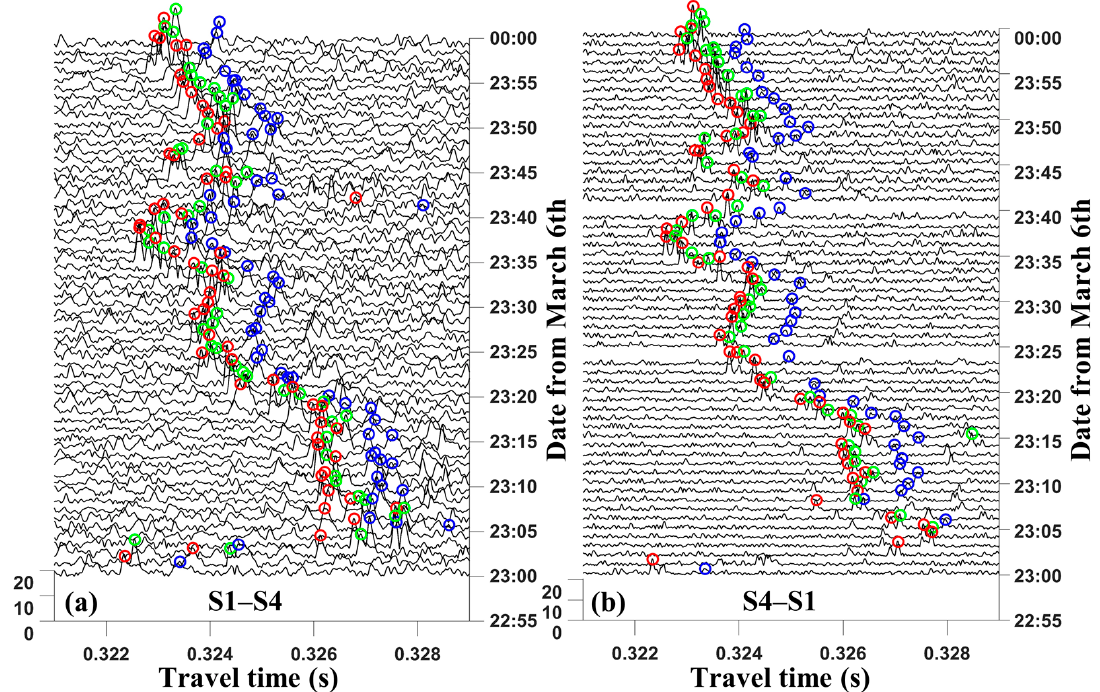
validation. In Figure 6, red lines represent direct rays (D), green lines represent surface reflected rays (SR), and blue lines represent bottom reflected rays (BR).